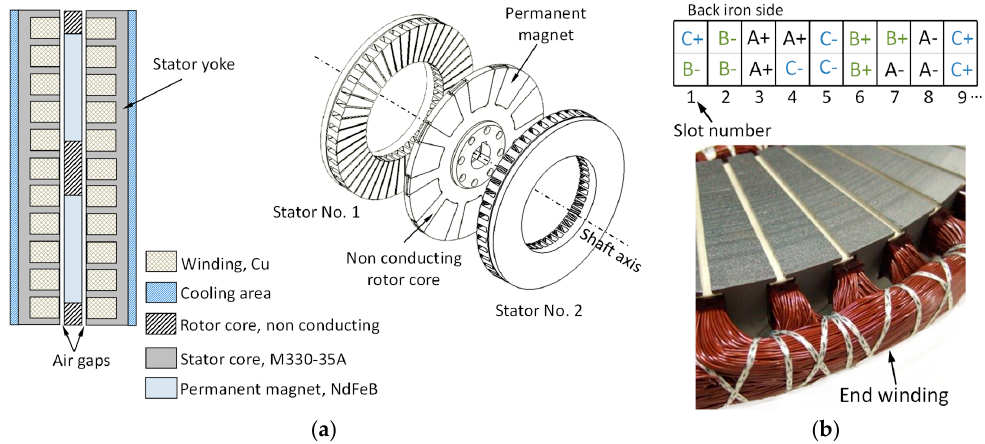
Figure 2. The motor topology of the AF PMSM: ( a ) Major components; ( b ) winding sequence; due to rotational symmetry, only 1/5 of a section is shown with the wound stator core.